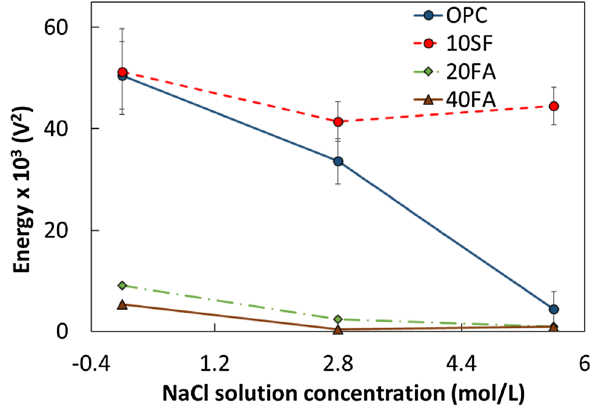
Fig. 10 Energy of the ultrasonic response at day 14 (the error bars indicate ± one standard